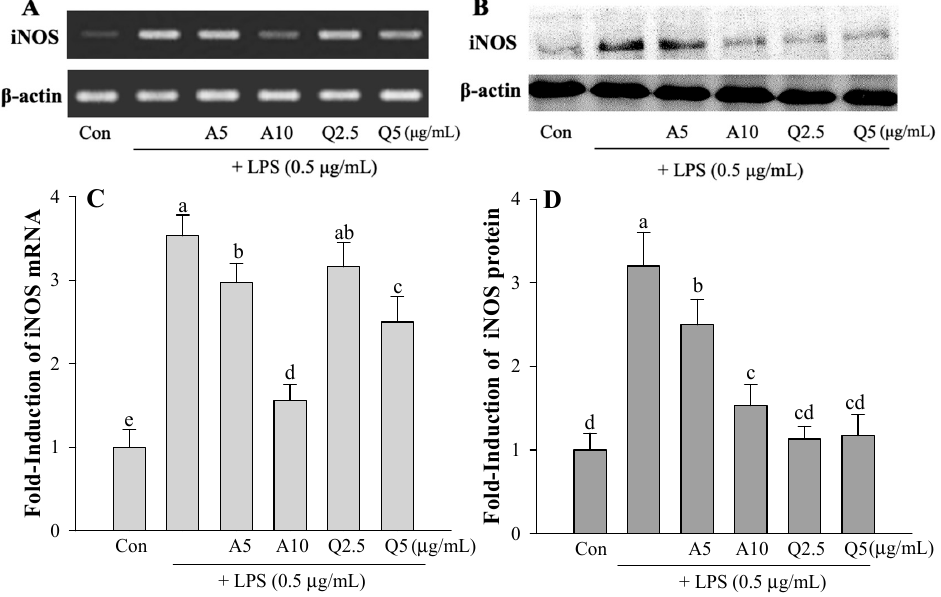
Figure 4. Effect of Ast (A) and Que (Q) on ( A , C ) iNOS mRNA and ( B , D ) iNOS protein in LPS- activated microglia. Con, control: LPS- and sample-untreated cells; Group LPS: cell treated with LPS only. The level of iNOS mRNA and protein content in each sample were normalized by comparing to the β -actin content. Both mRNA and protein band density were quantified using SigmaGel software. Results are provided as the ratio of each mRNA or protein in treated cells-to-that of the untreated control. The values shown are the mean ± SD ( n = 3) and means labelled with different letters (a–e) differ significantly as shown by Duncan’s multiple range test ( p < 0.05). There was increased TNF- α and IL-1 β release in cells exposed to 0.5 μ g/mL LPS ( p < 0.05) compared with the control (Figure 5). When simultaneous co-treatment with samples (Ast or Que) and LPS (0.5 μ g/mL) was applied, the stimulatory effects of LPS on TNF- α and IL-1 β protein levels were blocked by the flavonoids. At a concentration of 5 μ g/mL, Ast and Que inhibited the TNF- α production by 6.7- and 5.9-fold lower than the LPS group (10.5-fold) (Figure 5A). Similarly, LPS-stimulated IL-1 β release was also significantly inhibited in a dose-dependent manner by Ast and Que (Figure 5B). T N F - α p r o t e i n ( F o l d s o f c o n t r o l ) 024 681012